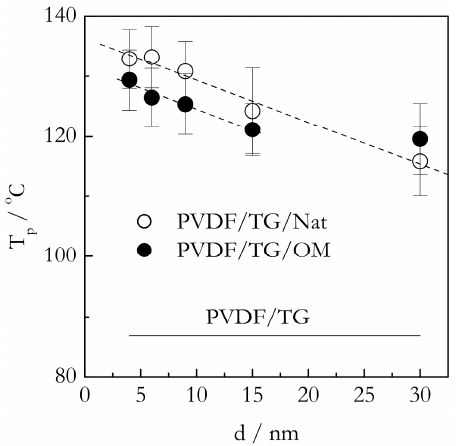
Figure 5. DSC peak temperatures for gelation of PVDF/TG bulk (solid line), and confined systems, PVDF/TG/Nat (open circles), PVDF/TG/OM (solid circles) vs. the pore diameter. Dashed line is a guide to the eye.